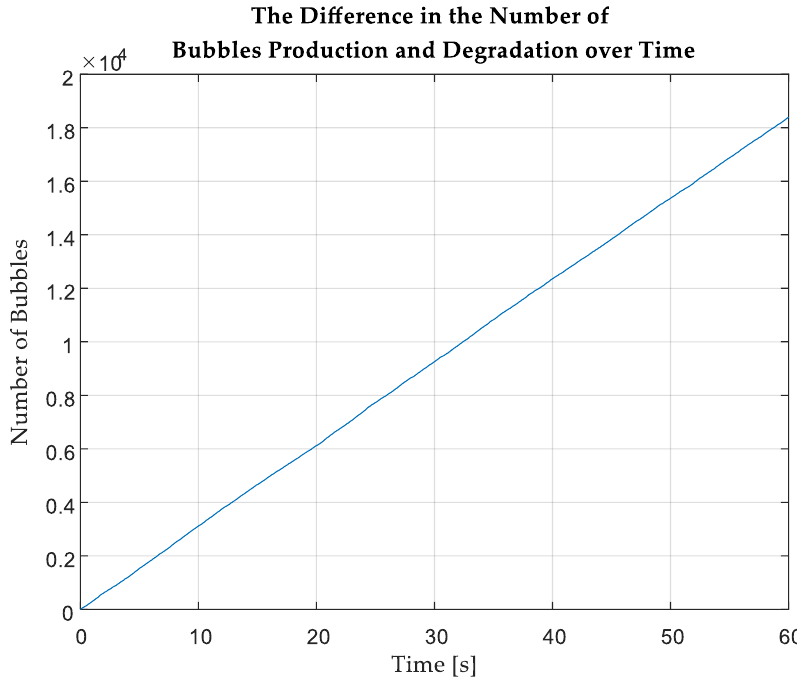
Figure 6. Simulation 2 — number of additional bubbles with time.